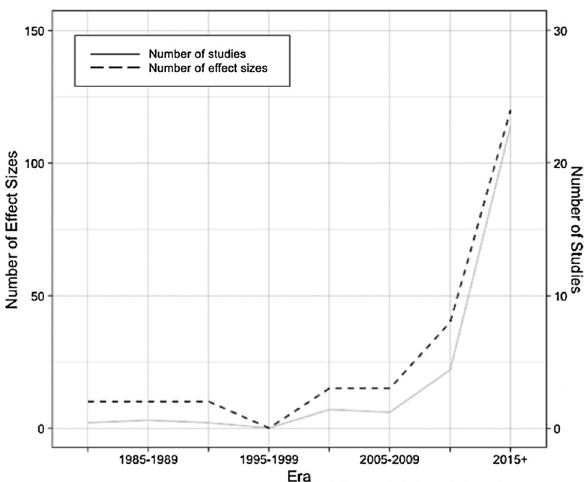
Figure 2. Number of studies and effect sizes over